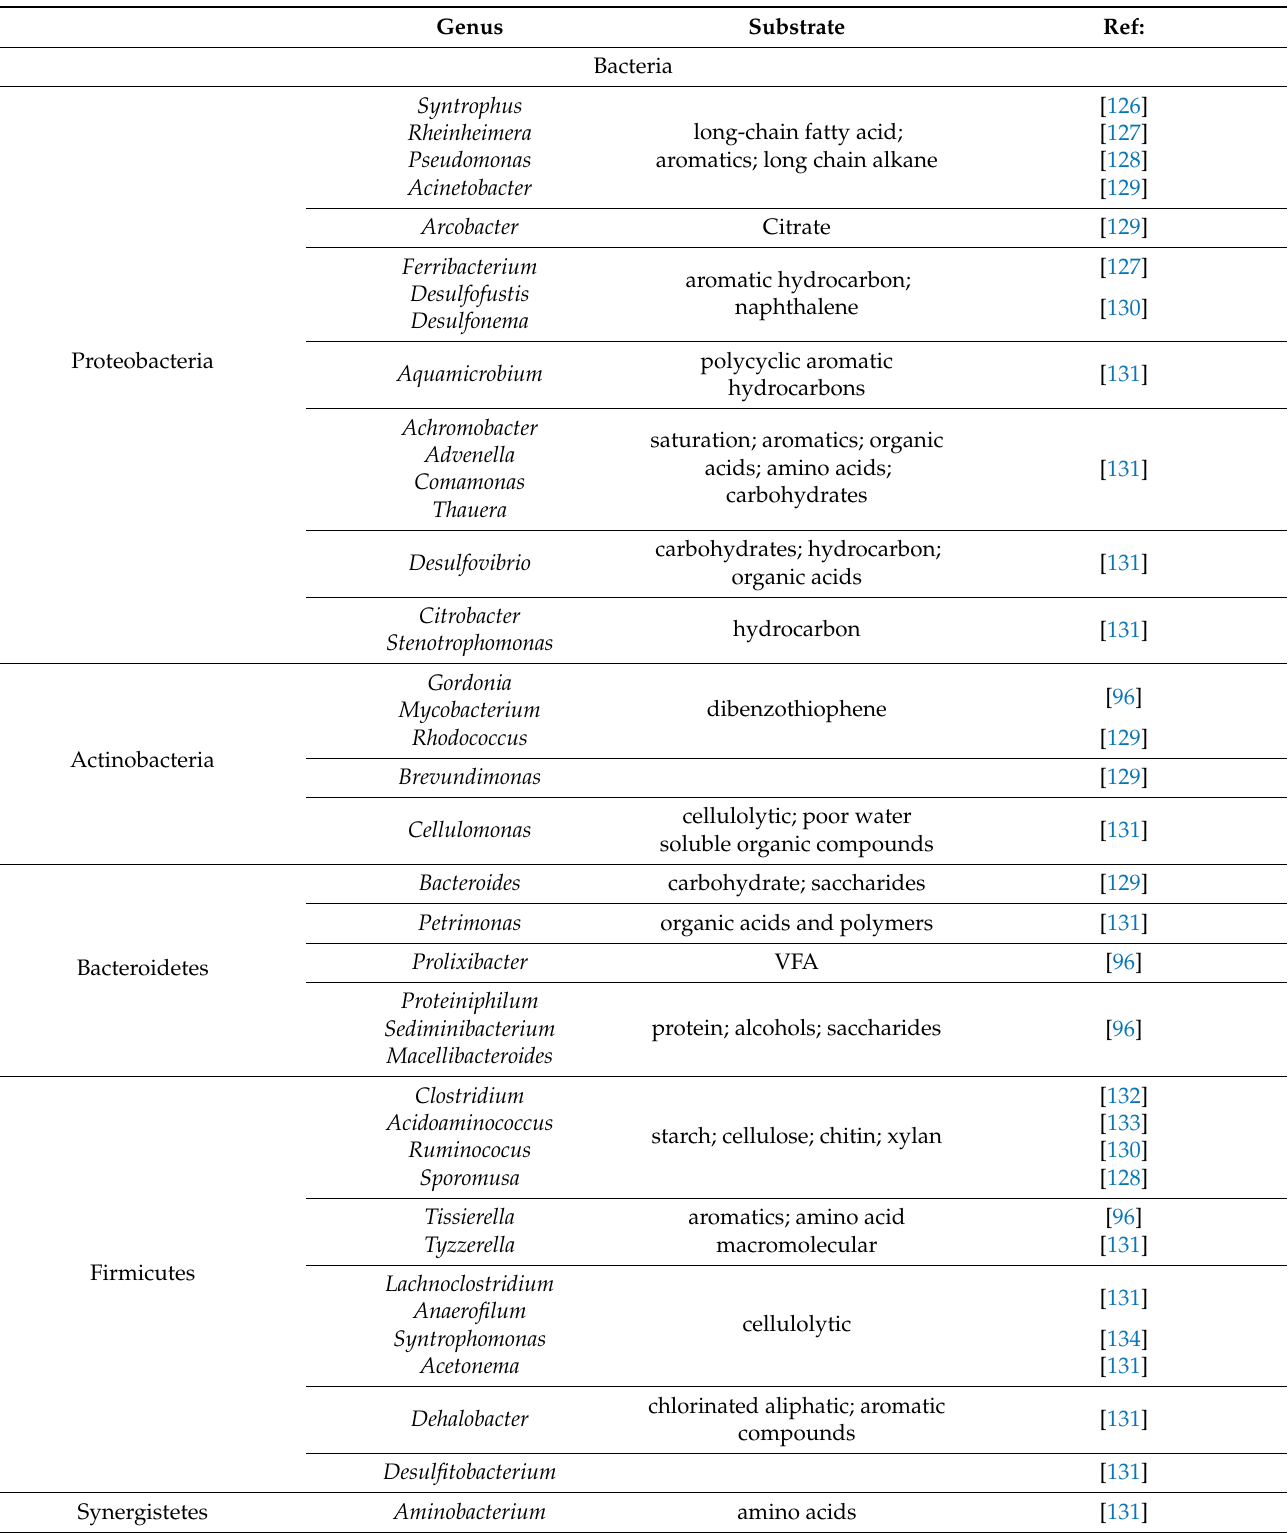
Table 4. Bacterial and archaeal genera found in microbial